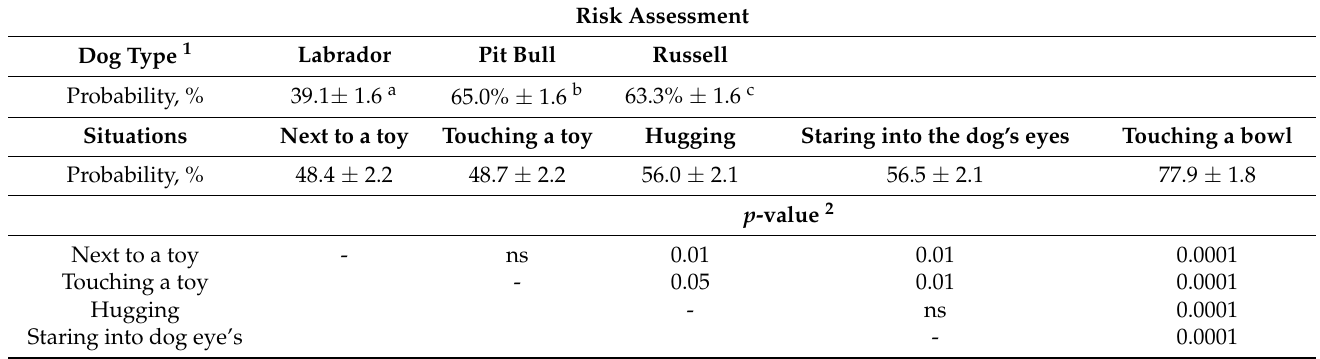
Table 1. Differences in the probability of the risk assessment between dog types (upper section) and various situations (lower section). Data are presented as LS means ± standard error included p -values.